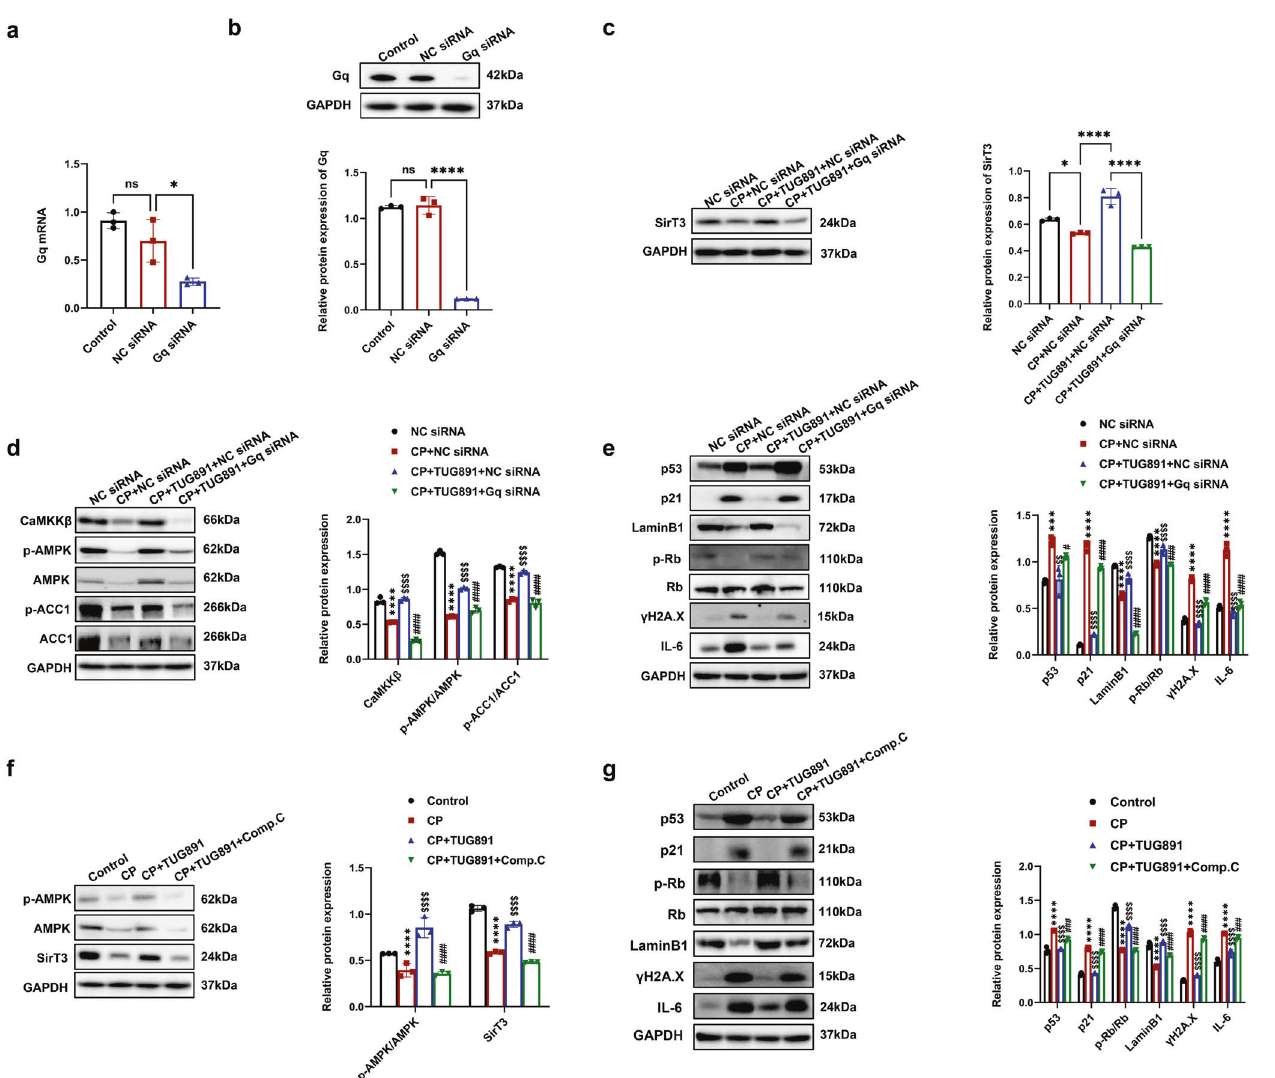
Fig. 9 Activation of FFAR4 reversed the Sirt3 expression via Gq/CaMKK β /AMPK signaling in cisplatin-stimulated TCMK-1 cells. a , b Relative mRNA and protein expression of Gq in TCMK-1 cells transfected with Gq siRNA ( n = 3; * P < 0.05, **** P < 0.0001, ns no signi fi cant difference). c Protein expression of SirT3 in TCMK-1 cells transfected with Gq siRNA detected by western blotting and quanti fi ed by densitometry ( n = 3; **** P < 0.0001, * P < 0.05). d Protein expression of CaMKK β , p-AMPK/AMPK, and p-ACC1/ACC1 in TCMK-1 cells transfected with Gq siRNA detected by western blotting and quanti fi ed by densitometry ( n = 3; **** P < 0.0001, CP + NC siRNA vs. NC siRNA; $$$$ P < 0.0001, CP + TUG891 + NC siRNA vs. CP + NC siRNA; #### P < 0.0001, CP + TUG891 + Gq siRNA vs. CP + TUG891 + NC siRNA). e Protein expression